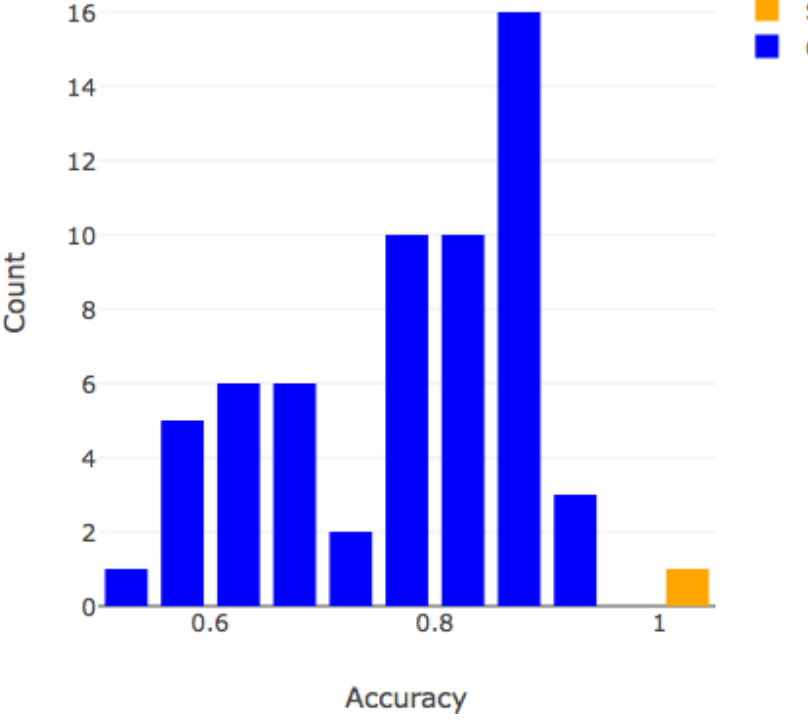
Figure 8. Comparison of the subpath Kernel (SPK) with other major tree kernels in accuracy. The dataset used consists of 50 fake DOM trees and 50 authentic DOM